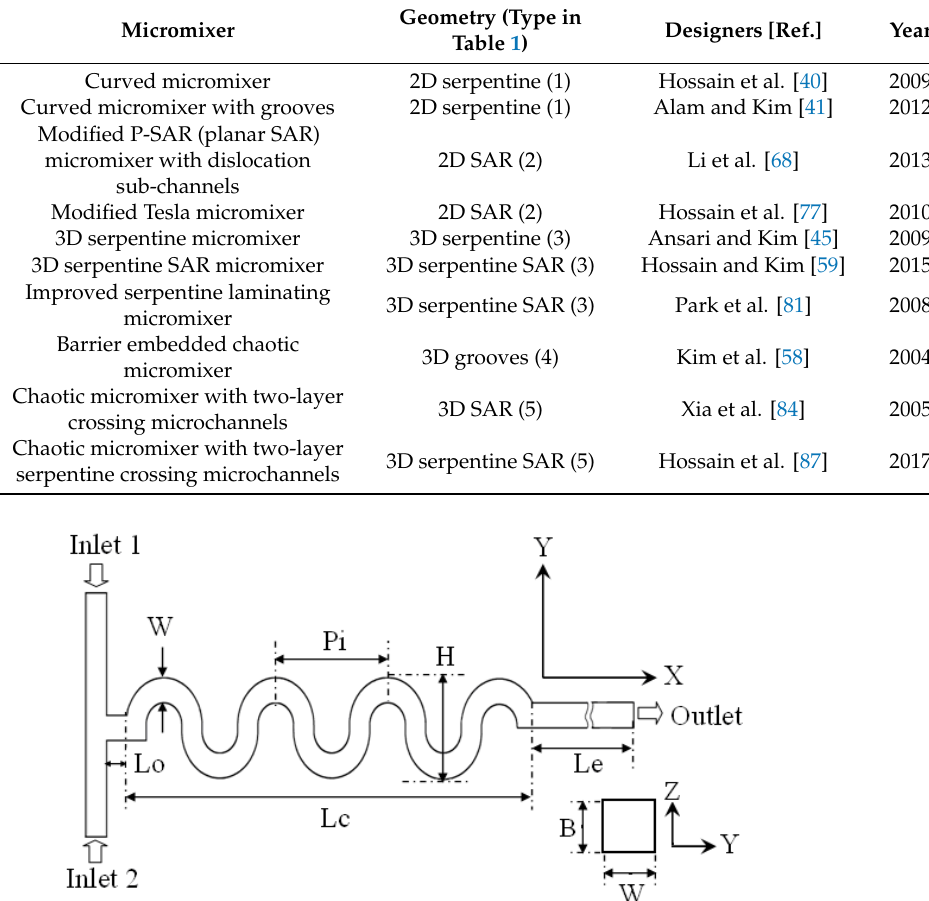
Table 2. Selected micromixers.